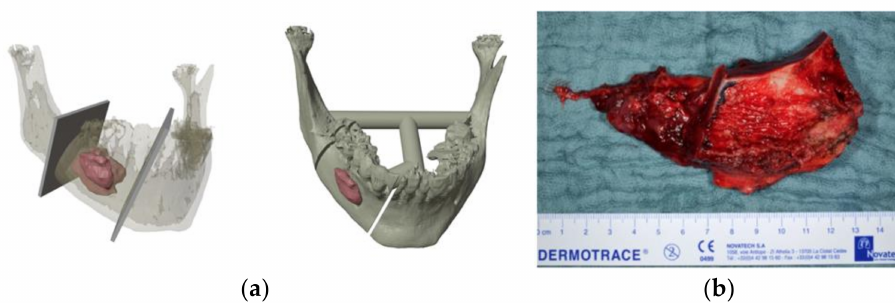
Figure 5. Illustration of ( a ) preoperative 3D osteotomy planning and ( b ) intraoperative image of DCIA flap for